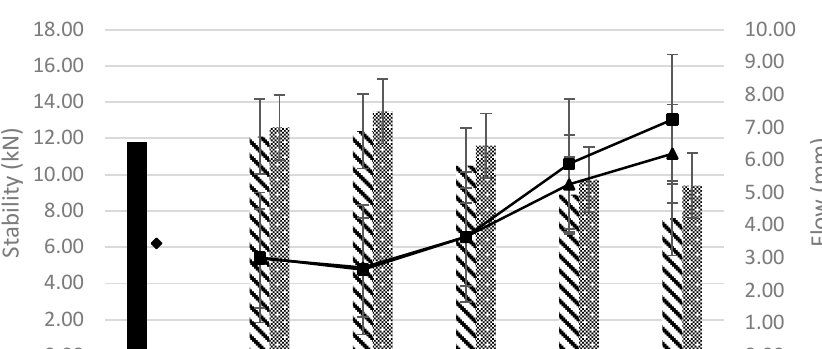
Figure 12. Moisture susceptibility test.